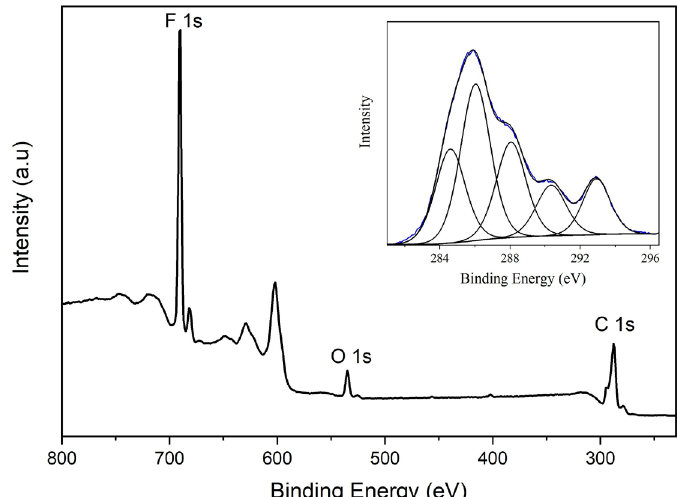
Figure 7. XPS spectra of a fluorocarbon coating deposited on Si substrate. The insert shows the C 1s high resolution spectrum.